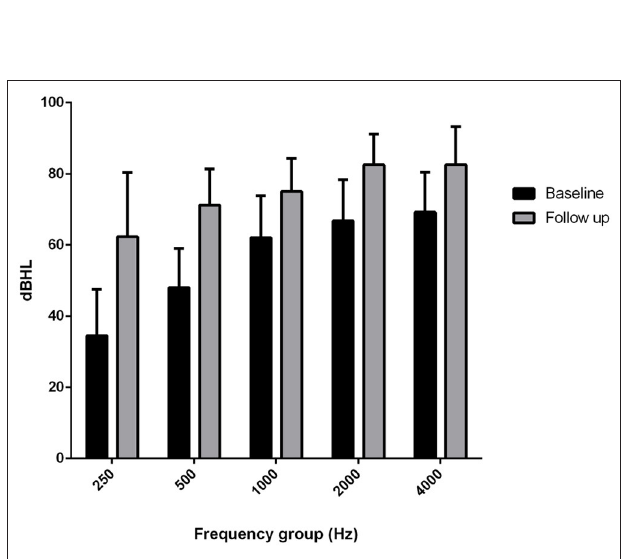
FIGURE 2 | Bone conduction threshold levels in the Esteem-implanted ear: baseline vs. follow-up (4–12 years).